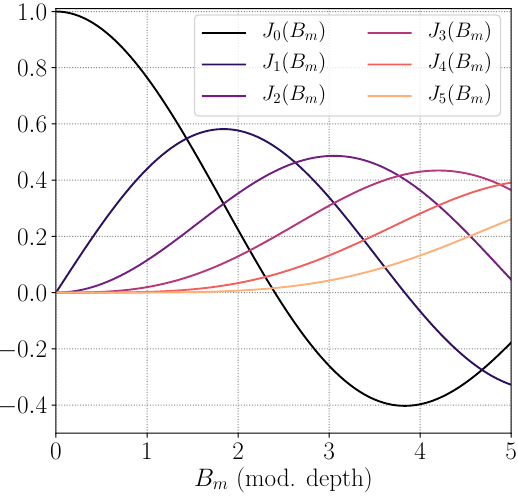
Figure 3: A plot of the first six phase-modulation coefficients as a function of the modulation amplitude. The coefficients are given by the Bessel functions of the first